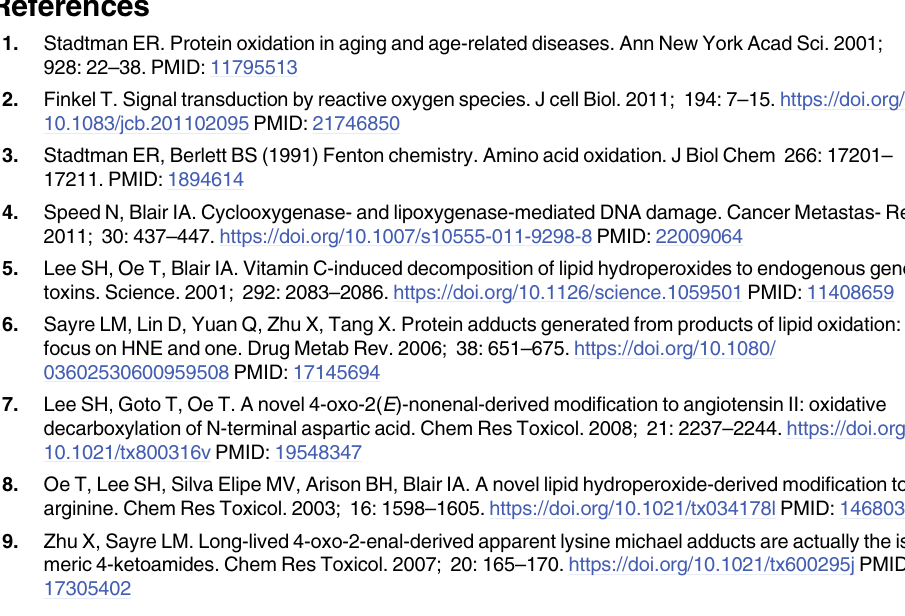
S2 Table. List of HNE-modified HSA peptides identified from the reaction between HSA (30 μM) and HNE (300 μM). (cid:3) indicates a modification site. O indicates a peptide identified automatically. Δ indicates a peptide identified manually. S3 Table. List of ONE-, HNE-, and HPNE-modified HSA peptides identified from the reac- tion of HSA with 13-HPODE in the presence of AscA. (cid:3) indicates a modification site.